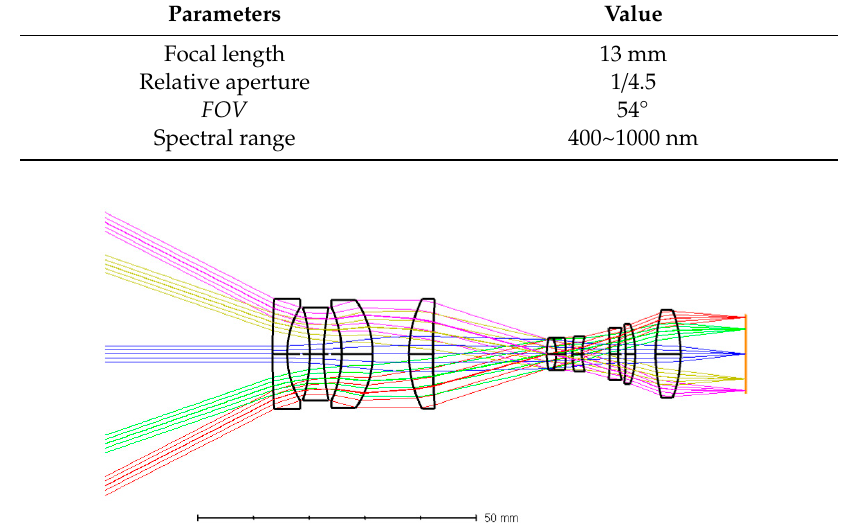
Table 4. Optical parameters of the objective.